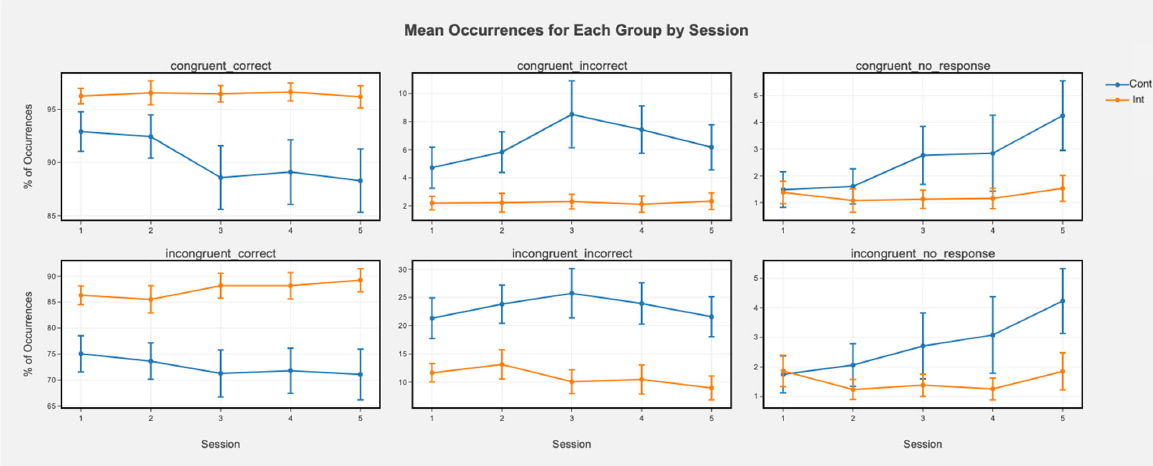
Figure 3. Mean occurrences (%) of each trial type for each group by session in the Flanker task. Greater % of correct trials means greater accuracy, while greater % of incorrect means lower accuracy (more errors). Error bars represent +/ − SEM. Error bars represent +/ − SEM. Cont represents the control condition and Int represents the intervention condition.